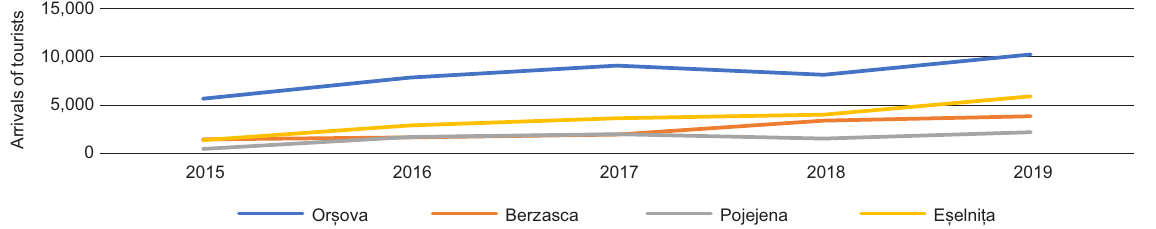
Fig. 8. Localities that have recorded increases in tourist arrivals. Source: own study.